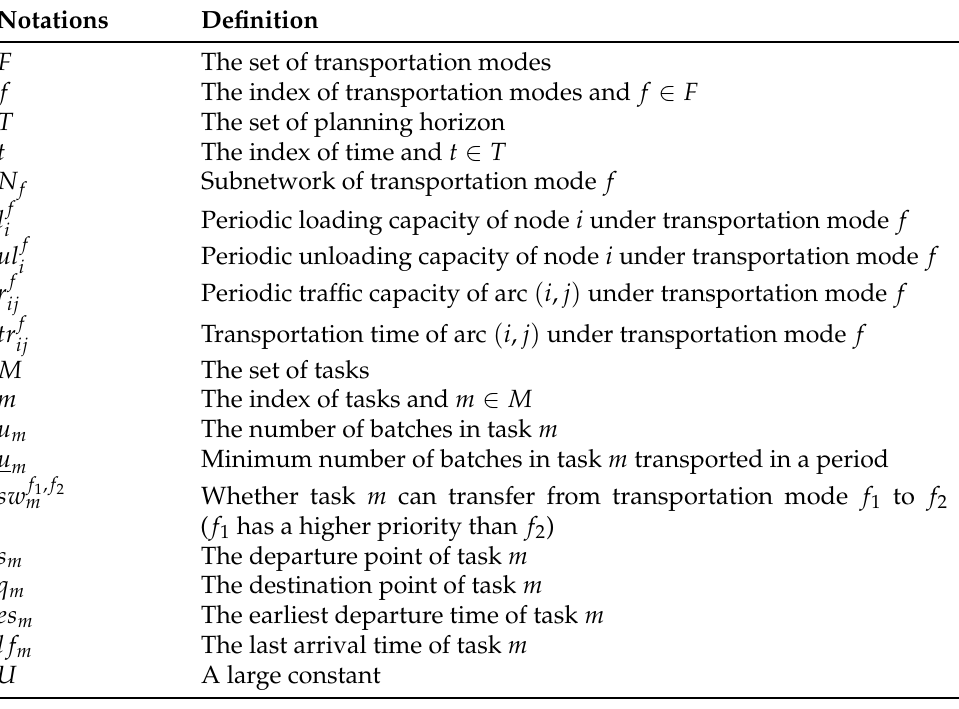
Table 1. Notations of related parameters used in the models.